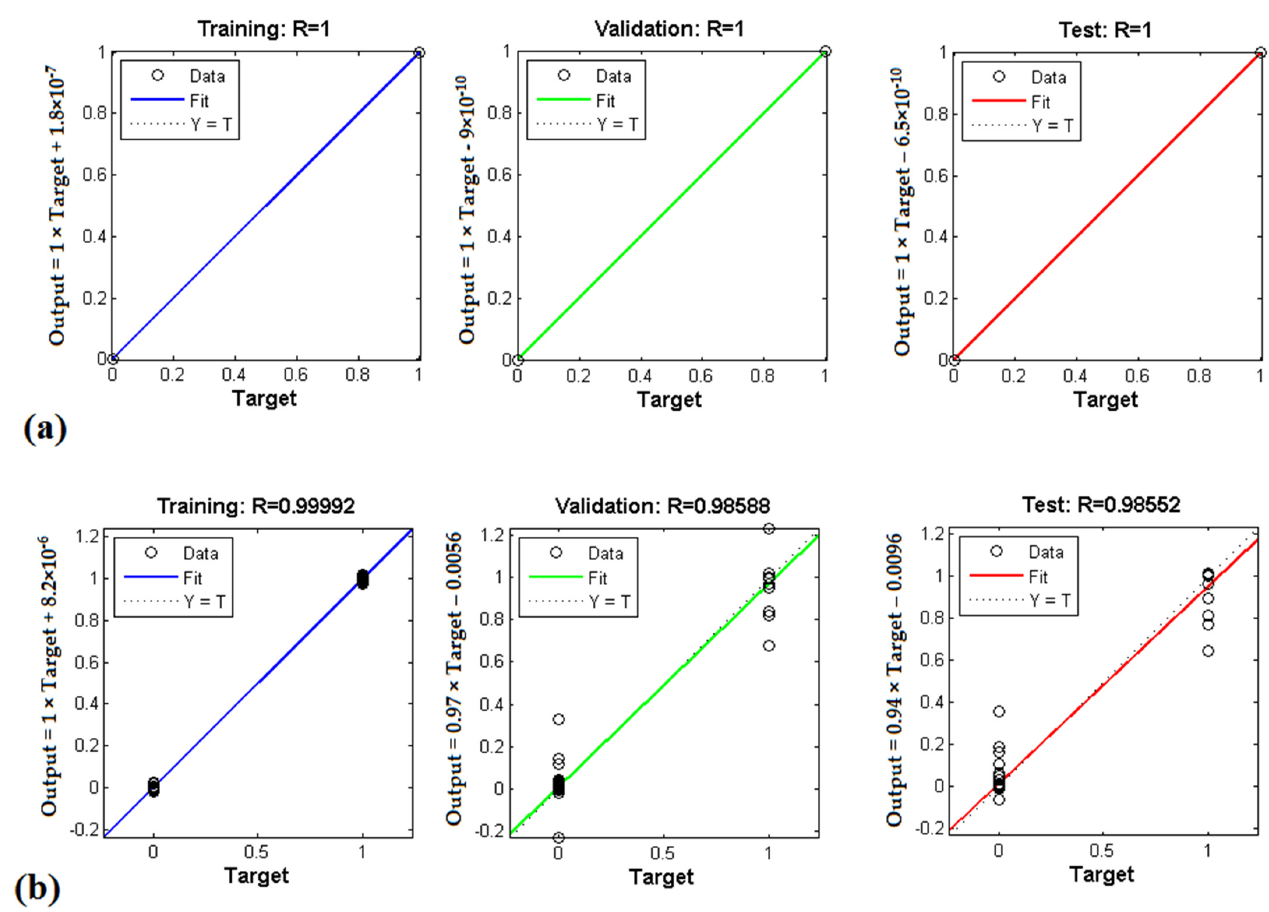
Figure 7. Linear regression correlation of target (expected) vs. output (actual) values from ANN-structured analyses for predicted and measured data for: ( a ) 2-group, ( b ) 6-group essential oil aroma classifications.